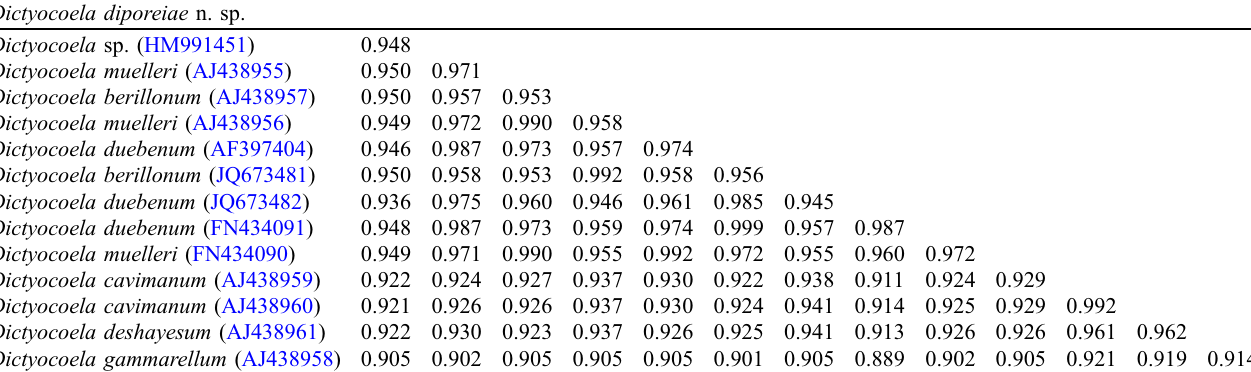
Table 2. Pairwise genetic distances between Dictyocoela diporeiae n. sp. and similar Dictyocoela strains based on nearly full-length 16S small subunit rDNA